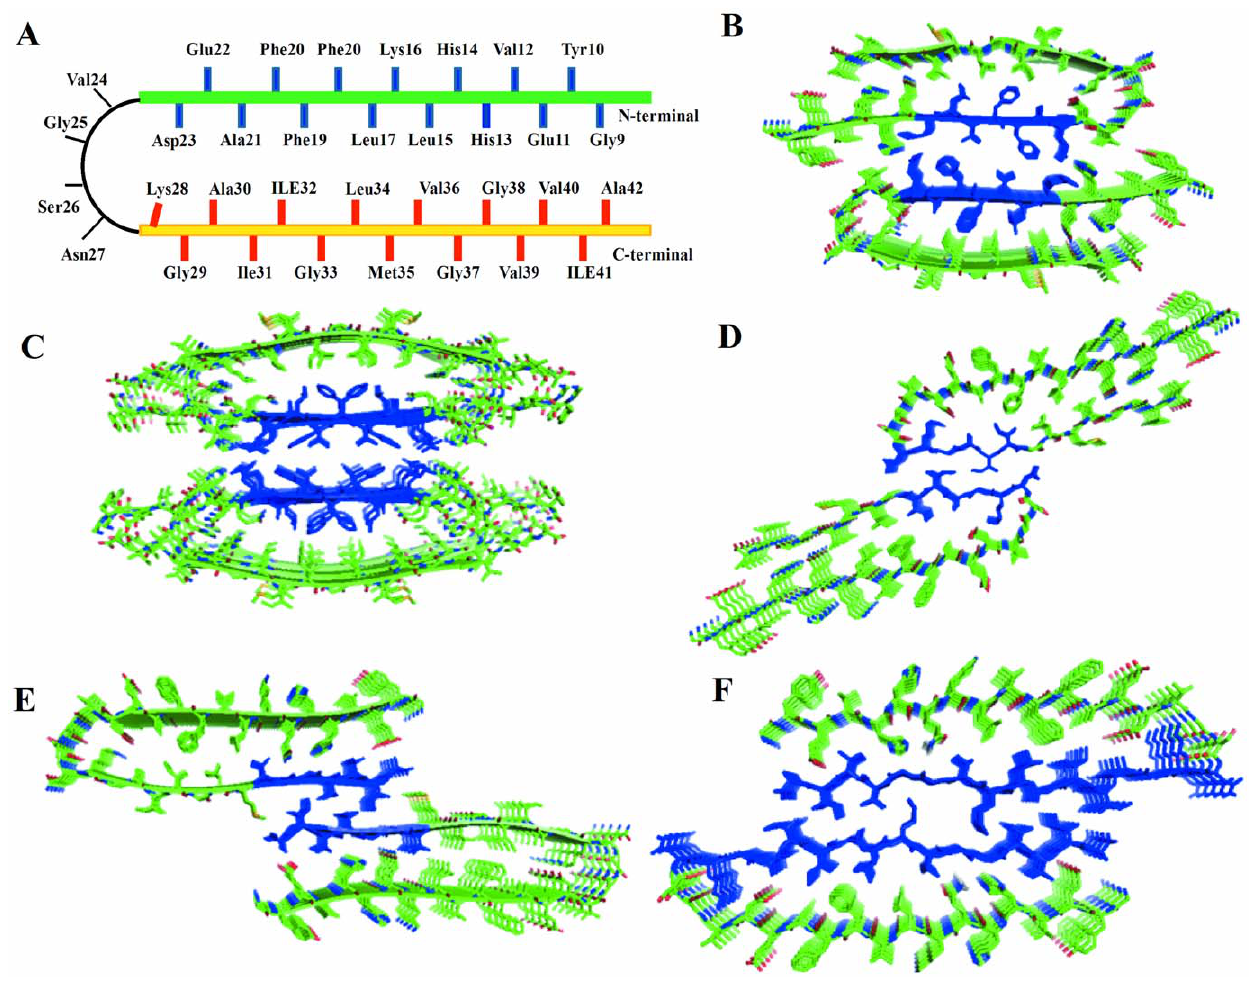
Figure 1. Structural models of double-layer A b segmental polymorphism proposed by Eisenberg group. (A) Schematic representation of the U turn structure of A b single layer based on ss-NMR. The first beta sheet (green) and the second beta sheet (yellow) are represented by a thick line. The thin (black) line represents the loop region that connects the two sheets. The crystal structure of A b 16 2 21 form II (blue) serves as an interface for model 16–21P (Figure B) and model 16–21AP (Figure C) of A b 16 2 21 . The model 16–21AP displays antiparallel b sheet. In the model 27–32 (Figure D) interactions between double-layer A b is through the crystal structure of A b 27 2 32 . The model 35–42 in Figure 1 E is based on the crystal structures of A b 35 2 42 form II as the interface between double-layer A b . The fifth model (Figure 1F) is based on the long steric zipper interfaces consisting of A b 30 2 35 and A b 35 2 42 microcrystal structure. The blue color is used here to indicate the interfacial hydrophobic interactions based on the microcrystal